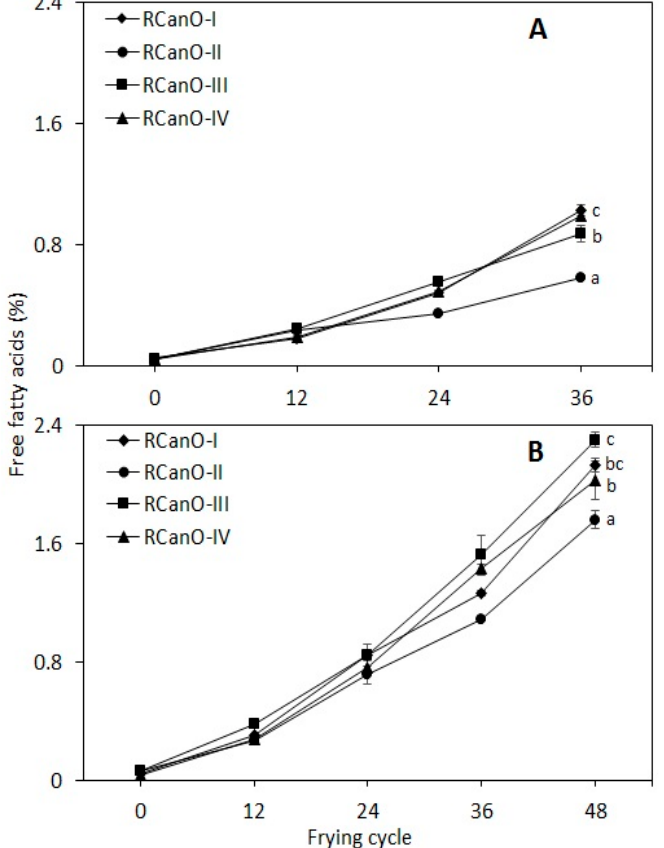
Figure 3. Formation of free fatty acids in canola oils during 36 and 48 frying cycles: ( A ) 2016/2017 ( n = 36) and ( B ) 2017/2018 ( n = 48) production seasons. Different letters show means that are statistically significant from each other ( p < 0.05).